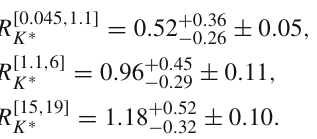
Table 1 Most prominent 1D patterns of NP in b → s μ + μ − . Pull SM is quoted in units of standard deviation 1D Hyp.